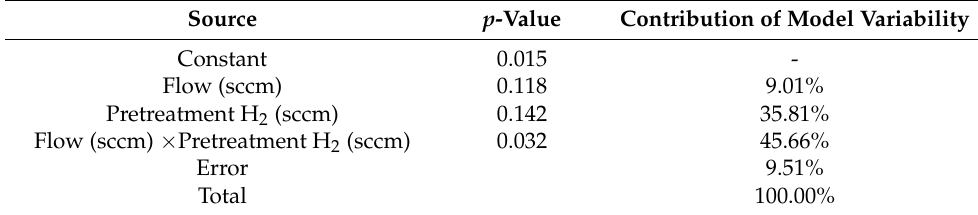
Table 3. Analysis of Regression Model Variance.